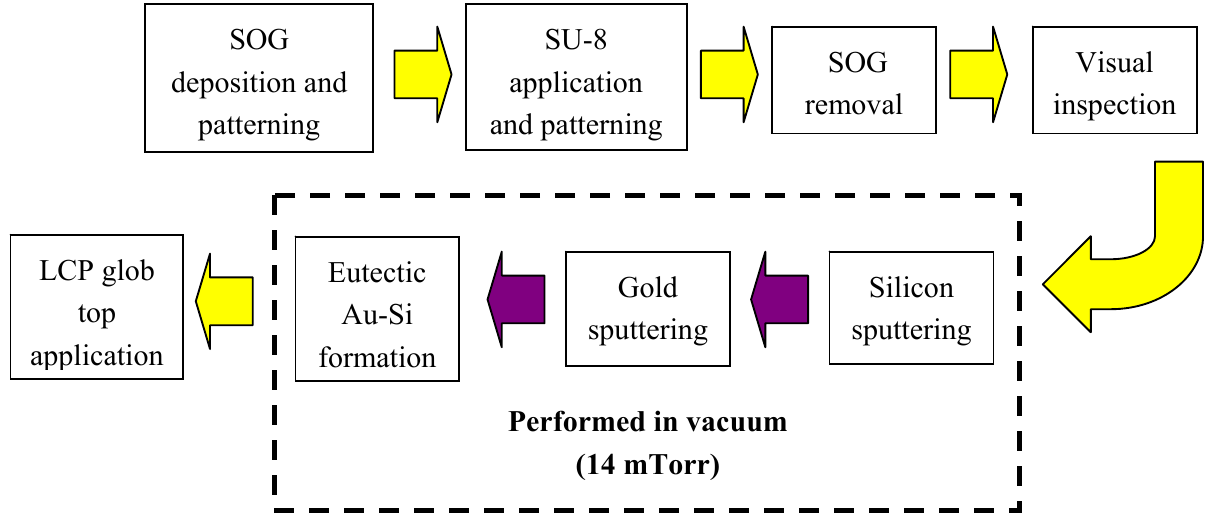
Figure 2. Process sequence for sputtered silicon encapsulation fabrication.